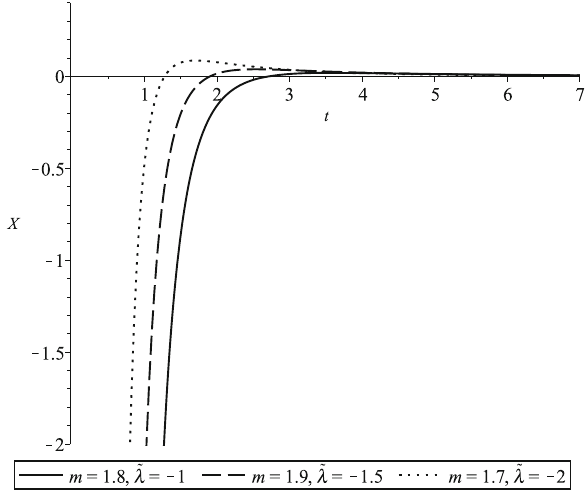
Fig. 3 Kinetic energy for different values of ˜ λ < 0 and m > 1